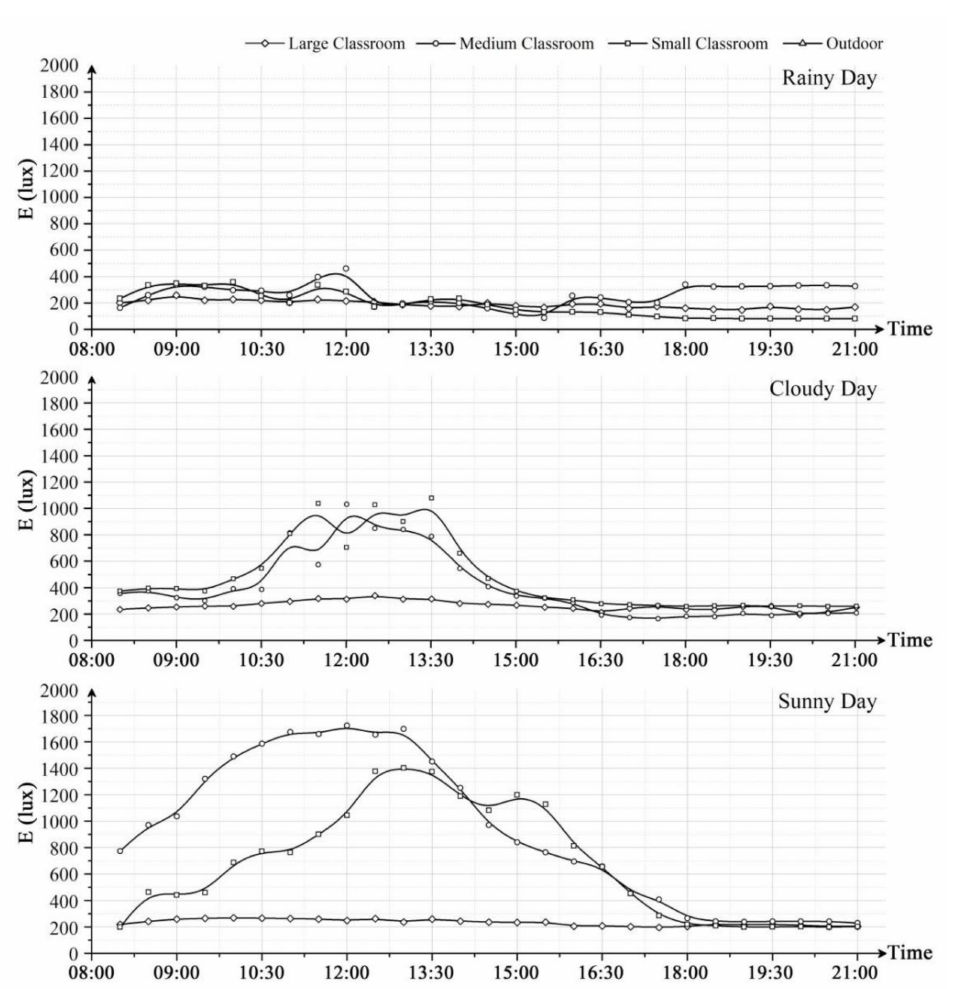
Figure 9. Central illuminance in the three classroom-types under different weather conditions throughout the